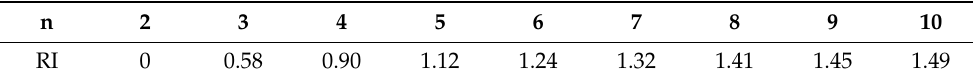
Table 4. The mean random index of 500